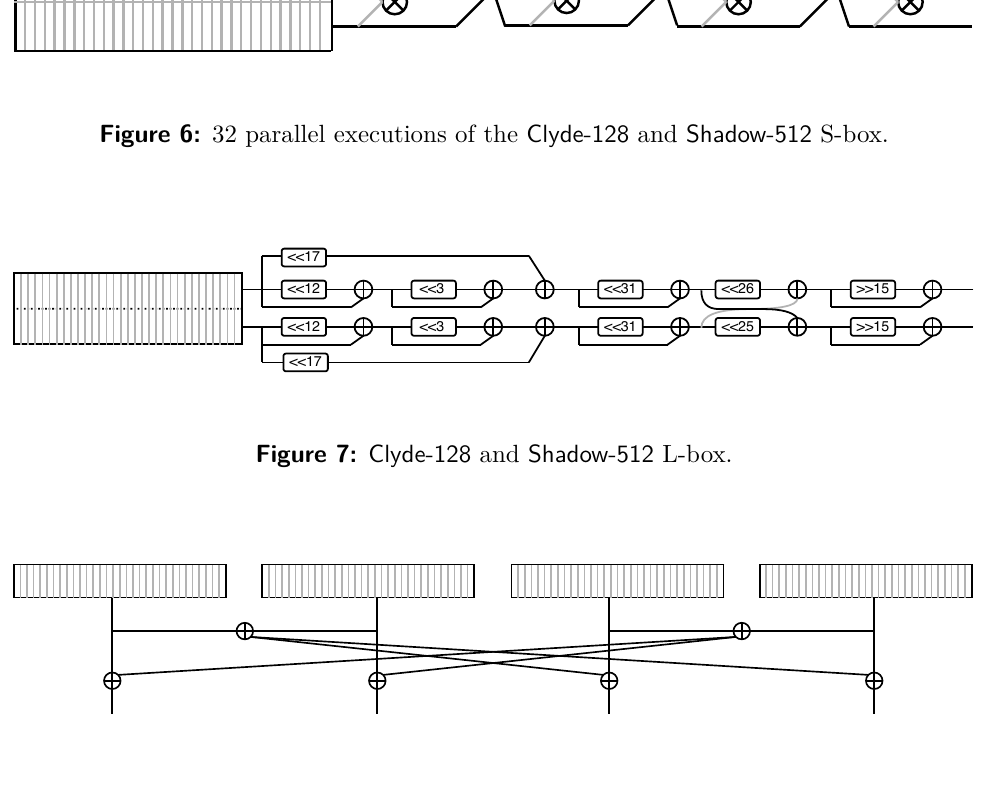
Figure 8: Shadow-512 diffusion